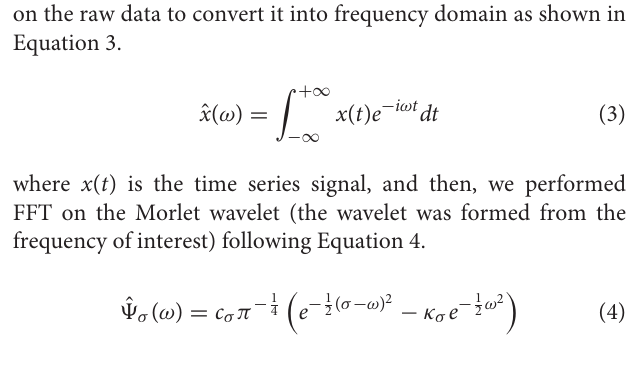
multiplication of a Gaussian with a sine wave and is described by the following